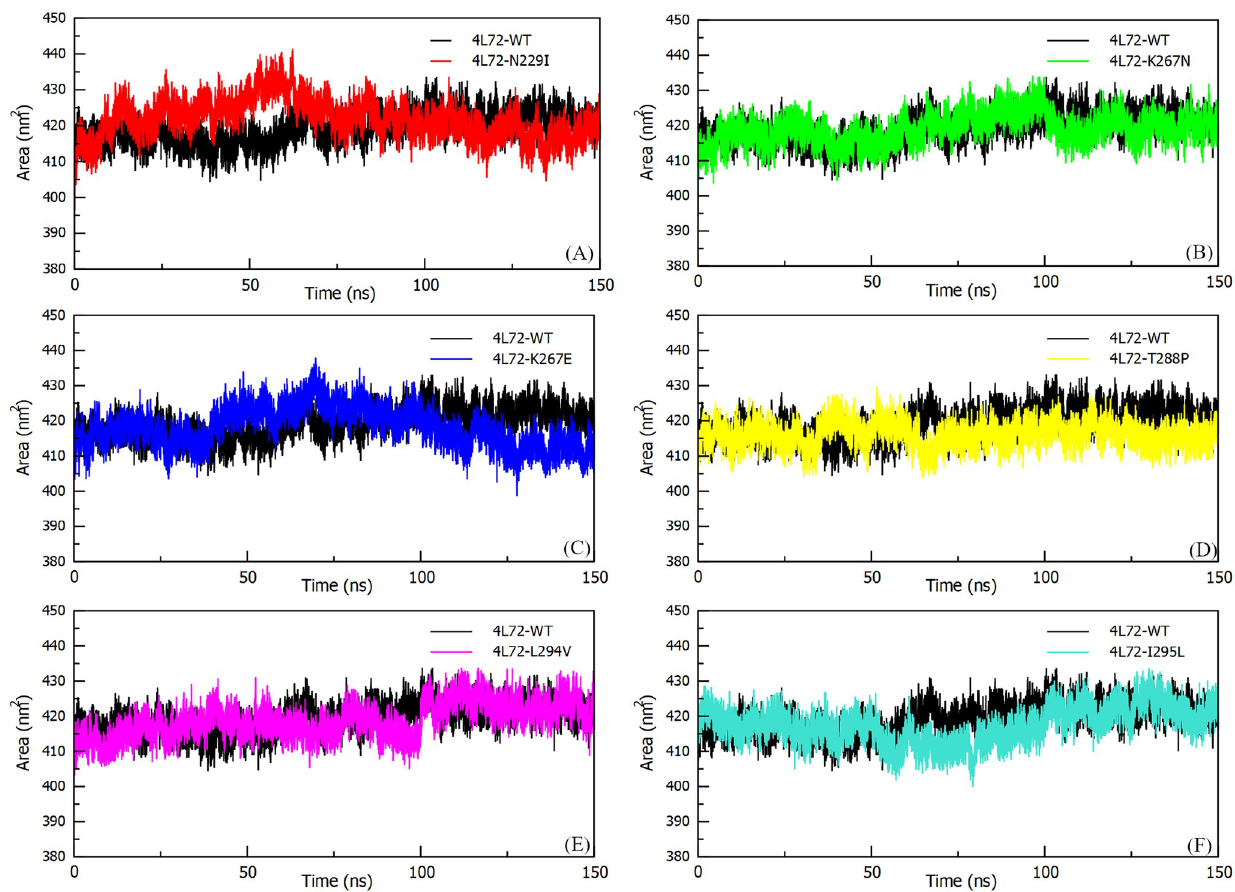
Fig 5. Solvent accessible surface area (SASA) between MERS-CoV S1 RBD protein and human DPP4 wild and mutant types during 150 ns of the molecular dynamics simulation period. (a) Rg 4L72-WT vs 4L72-N229I. (b) Rg 4L72-WT vs 4L72-K267N. (c) Rg 4L72-WT vs 4L72-K267E . (d) Rg 4L72-WT vs 4L72-T288P . (e) Rg 4L72-WT vs 4L72-L294V. (f) Rg 4L72-WT vs 4L72-I295L. SASA average value throughout the MD simulation, with an abrupt fluctuation between 40 and 60 ns for DPP4 -N229I structure prior stabilizing at SASA average value of 338 nm 2 (S3 Fig). Hydrogen bonds (H-bonds). Hydrogen bonds induce formation of secondary and ter- tiary protein structure. An increase of hydrogen numbers infer stronger PPI interactions. MD simulation of mutant models highlighted a notable increase in hydrogen interaction at the level of the complex formed during the interaction of DPP4 with MERS-CoV S1 RBD protein (Fig 6). Thus, the increase in hydrogen bonding implies a stability of the bond between the two proteins participating in the formation of the complex overtime regardless of conformation change in case of 4L72-N229I model. Yet, the average number of hydrogen bonds present at the interface between DPP4 and MERS-CoV S1 RBD during MD simulation was 8.012 +/- 2.672 in wild type model, while N229I mutant model returned the lowest h-bonds number (4.178 +/- 2.622) in 150 ns MD simulation reaching a null h-bonds at the interface of both pro- teins at 150 ns (Fig 7). Yet, other mutant models highlighted similar or stronger binding of complex protein as number of h-bonds present between their interfaces and was comparable or higher than wild type model (Fig 7).